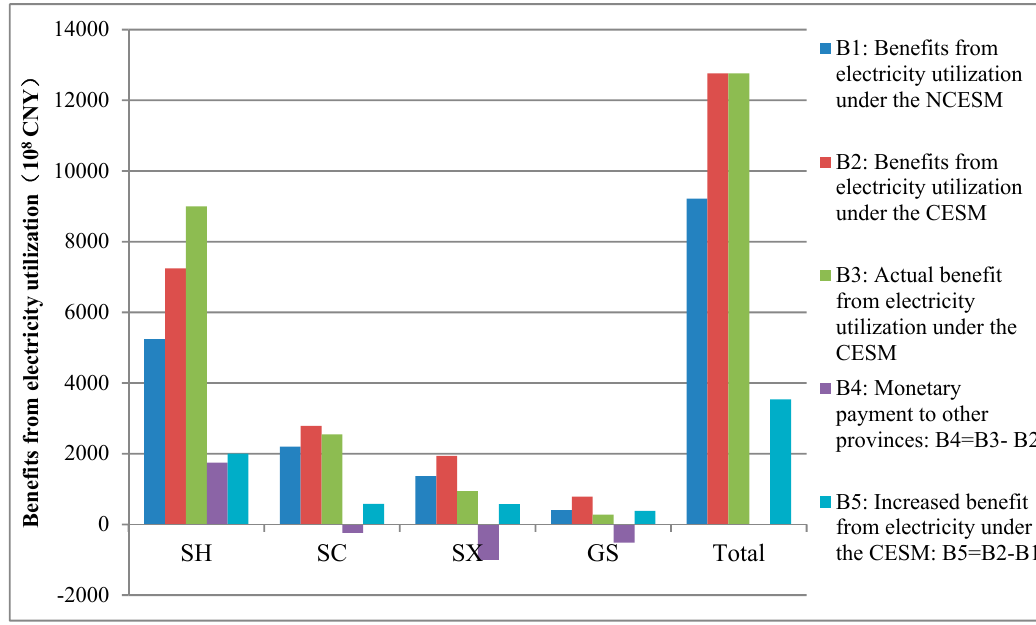
Figure 3. Comparison of benefits from electricity utilization under the CESM and the NCESM.